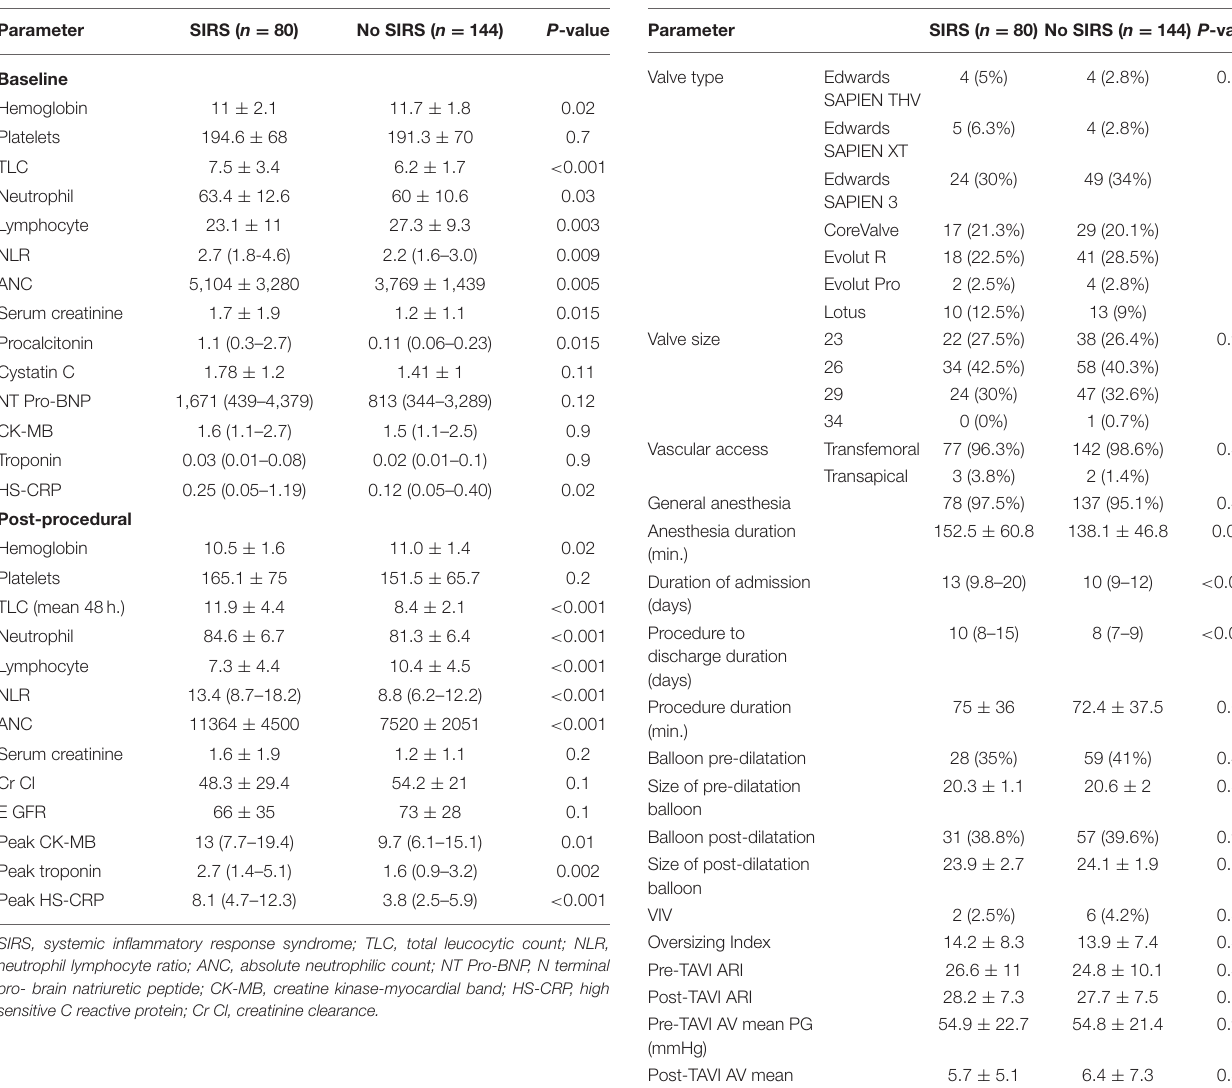
( Table 6 ). On univariate analysis, the pre-procedural Hgb level, serum creatinine, TLC, pre-TAVI heart rate (HR), post-TAVI systolic and diastolic blood pressures, as well as PASP were predictors of SIRS. However, on multiple regression analysis correcting for significant covariates, only pre-TAVI TLC, pre- TAVI HR, and post-TAVI SBP were independent predictors of SIRS.